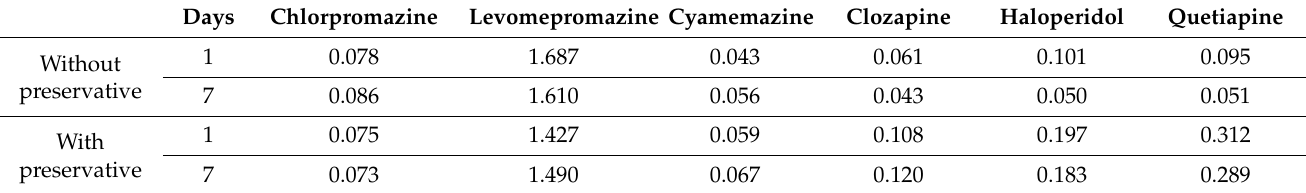
Table 2. Response of analytes with and without preservative after storage for 1 and 7 days at 4 ◦ C in the absence of